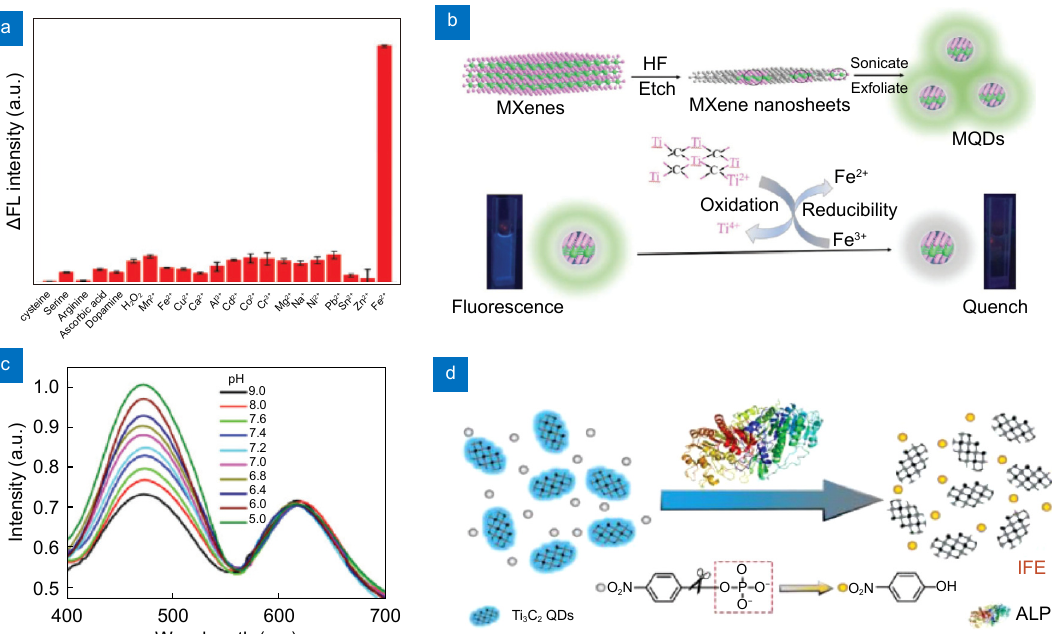
Fig. 10 | ( a ) The normalized fluorescence intensity of MQDs at 380 nm in the presence of various analytes. ( b ) The MQD synthesis process and working principle for Fe 3+ sensing. ( c ) Normalized PL spectra of [Ru(dpp) 3 ]Cl 2 and Ti 3 C 2 QDs in a buffer solution with different pH values ( λ ex = 350 nm). ( d ) The principle of Ti 3 C 2 QD-based fluorescence assay for ALP activity. The figures were reproduced with permission from: (a), (b) ref. 109 , (c) ref. 94 and (d) ref. 112 , Royal Society of